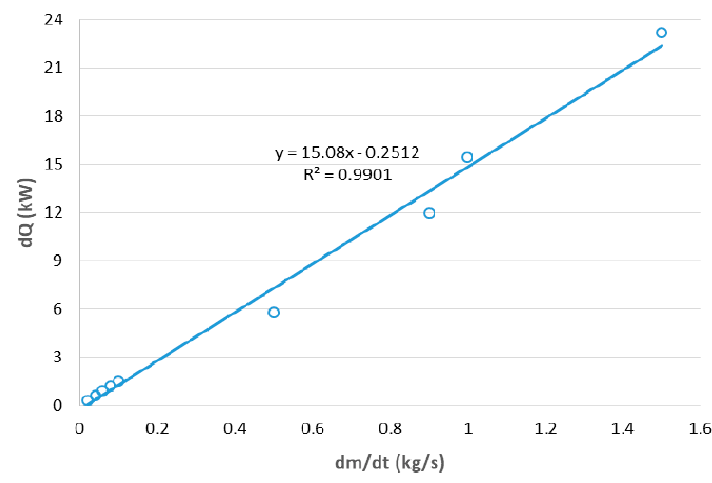
Figure 5. Heat transfer rate versus hot gas flow rate inside the dryer.